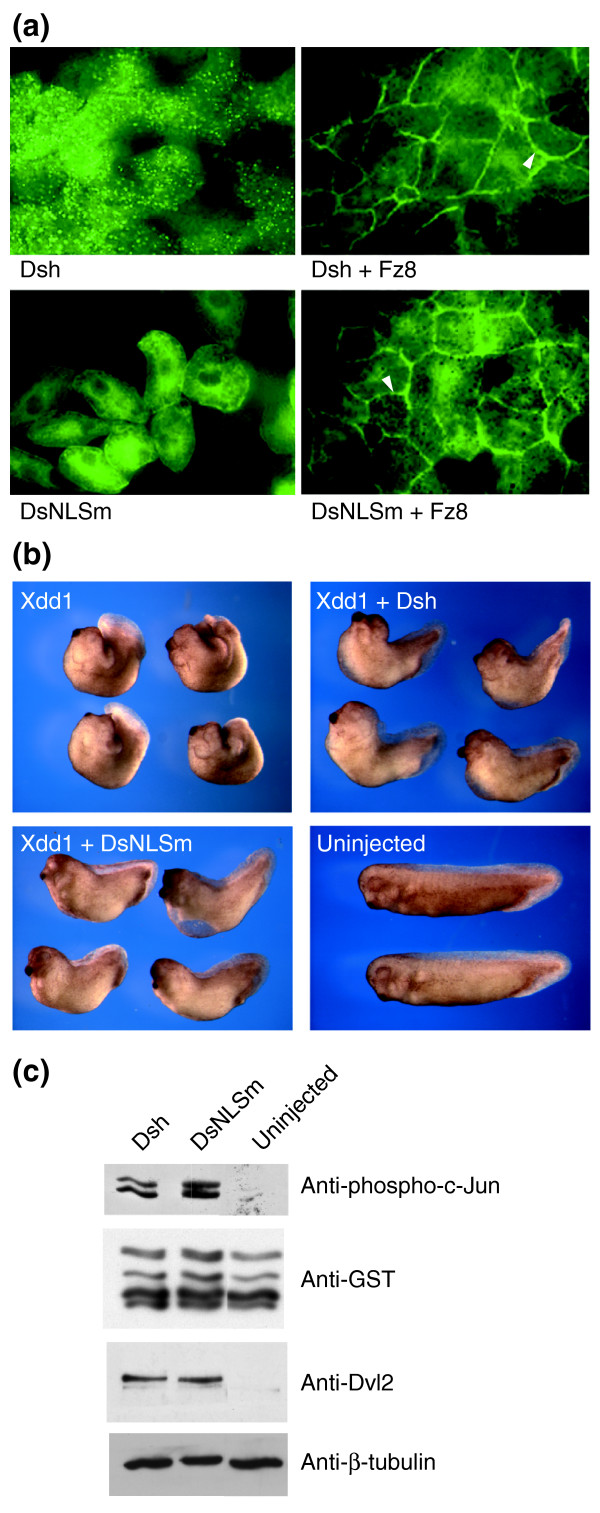
DsNLSm, defective in the β-catenin pathway, is active in noncanonical signaling. (a) Fz8-dependent recruitment of Dsh-GFP constructs to the cell membrane. Dsh-GFP or DsNLSm RNA (0.5 ng) was injected alone or with Fz8 RNA (1 ng) into two animal blastomeres at the 4–8-cell stage. GFP fluorescence was assessed in animal cap explants as in Figure 1b-d. Both Dsh and DsNLSm are efficiently recruited to the cell membrane by Fz8. Arrowheads point to cell membranes. (b) DsNLSm can rescue convergent extension defects caused by Xdd1. Four-cell embryos were injected with 0.6 ng Xdd1 RNA alone or together with 2 ng Dsh-GFP or DsNLSm RNA into two vegetal dorsal blastomeres. The injected embryos were allowed to develop until the sibling embryos reached stage 32. (c) Activation of JNK by the Dsh nuclear import mutant. Four animal blastomeres of four-cell embryos were each injected with 1 ng of RNAs encoding Dsh-GFP or DsNLSm. Embryonic lysates were collected at stage 10.5 for in vitro JNK activity assay using anti-phospho-specific c-Jun antibodies. Total GST-c-Jun levels were assessed with anti-GST antibodies. Dsh-GFP and DsNLSm were equally expressed, as monitored with anti-Dvl2 antibodies; β-tubulin served as a loading control.